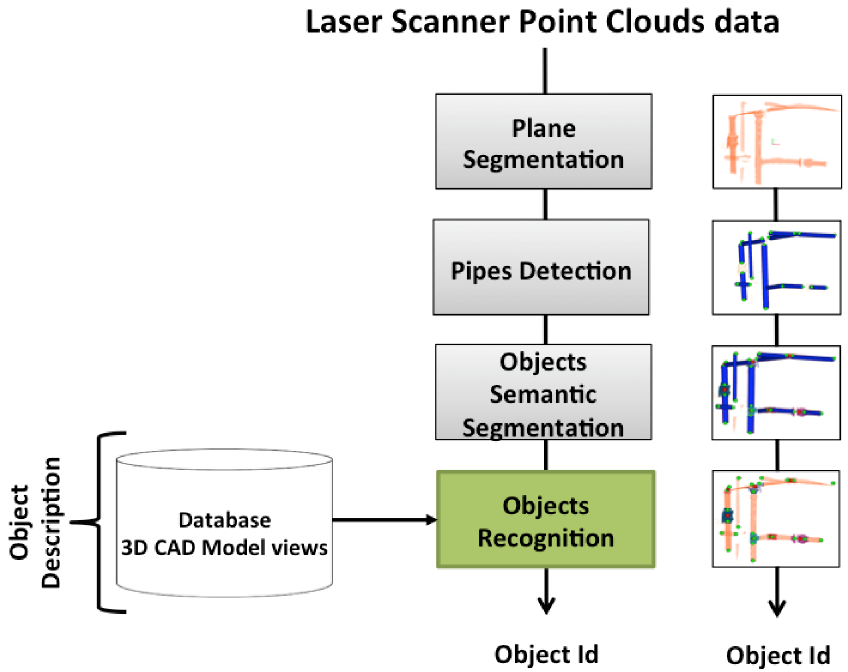
Figure 1. 3D Object Recognition Pipeline. Table 1. Polyvinylchloride (PVC) pressure pipes objects used in the